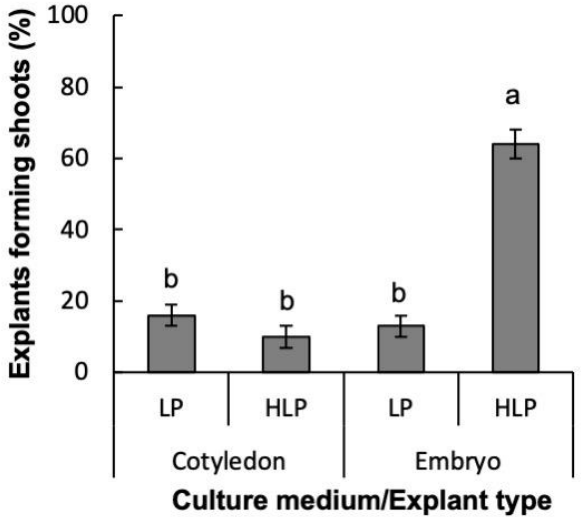
Figure 2. Percentage of explants forming shoots of Pinus ponderosa cotyledons or whole zygotic embryos cultured in LP or half LP macronutrients (HLP). Data are presented as mean values ± S.E. Different letters indicate significant differences according to Tukey’s post hoc test ( p < 0.05).